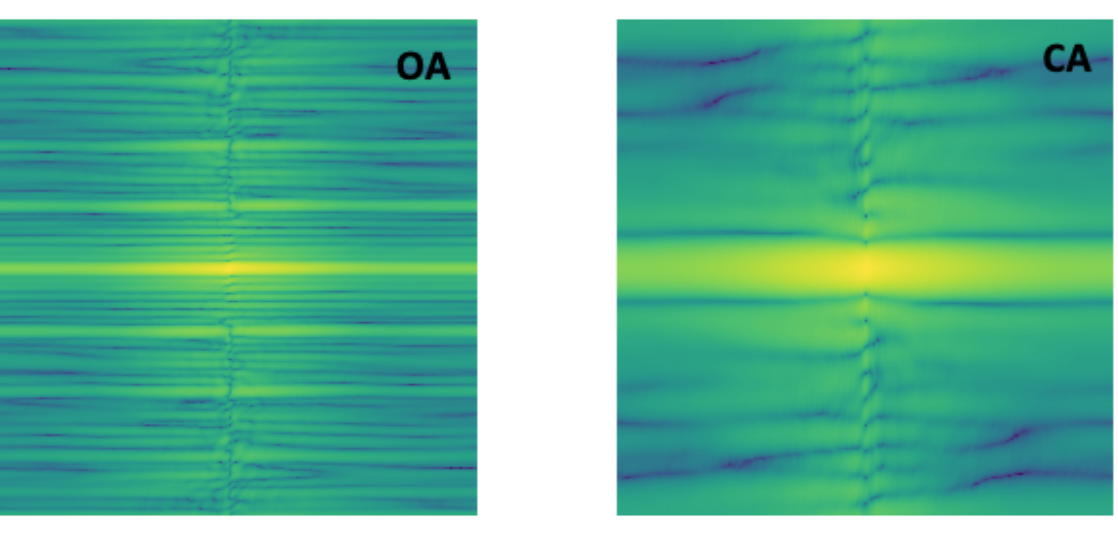
Figure 5. 2D fast Fourier transform (2DFFT) of movement histograms for OA and CA. 2DFFT images of OA have a wider frequency range as compared with CA, as breathing effort during OA causes more fluctuation in the movement signal. 2DFTT: 2D fast Fourier transform; CA: central apnea; OA: obstructive